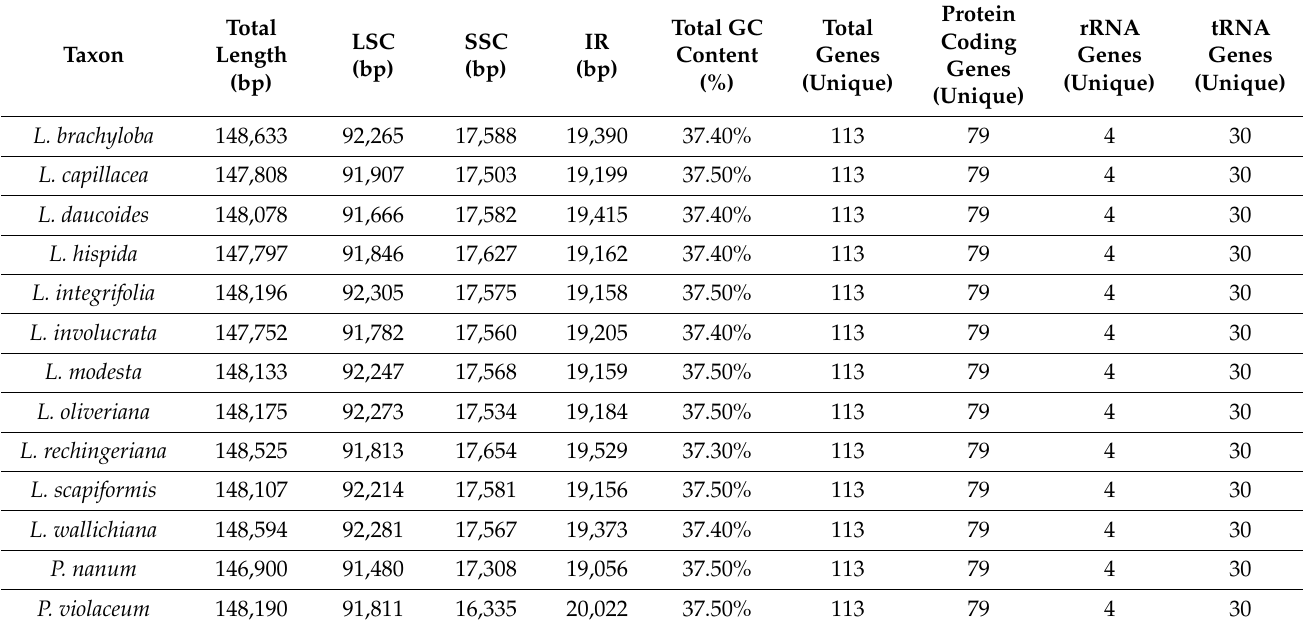
Table 1. Comparison of plastome features among Peucedanum nanum , P. violaceum , and Ligusticopsis